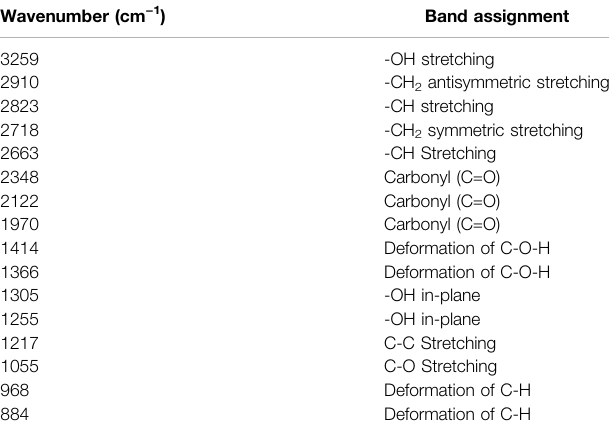
TABLE 1 | IR frequencies and assignments for functional groups in AME.